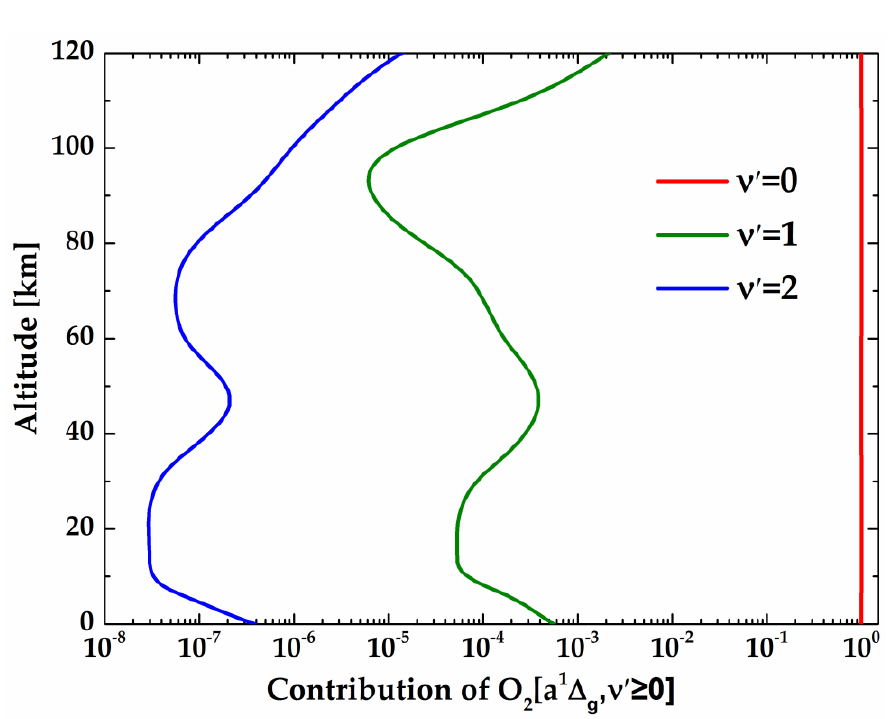
Figure 4. The calculated relative contribution of O 2 (a 1 ∆ g ) molecules at ν (cid:48) = 0, ν (cid:48) = 1, and ν (cid:48) = 2 as a function of altitude.